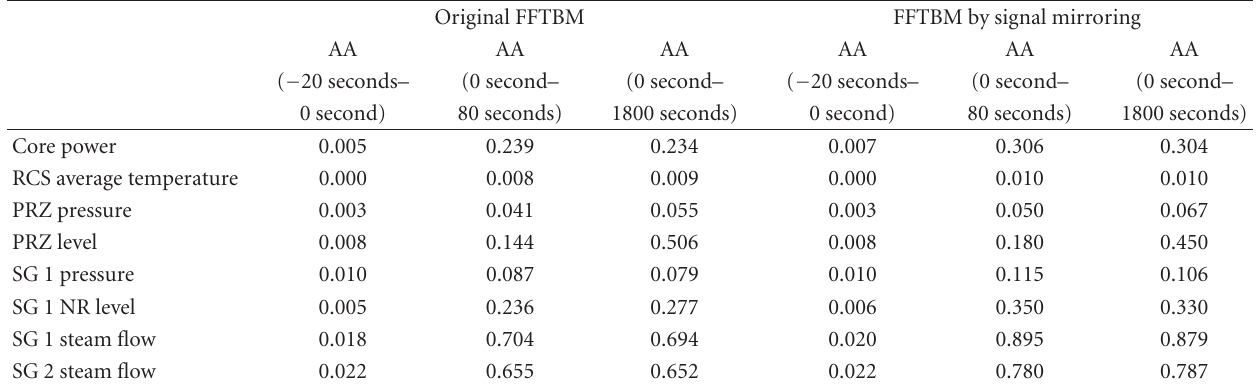
Table 4: Quantitative results for di ff erent time